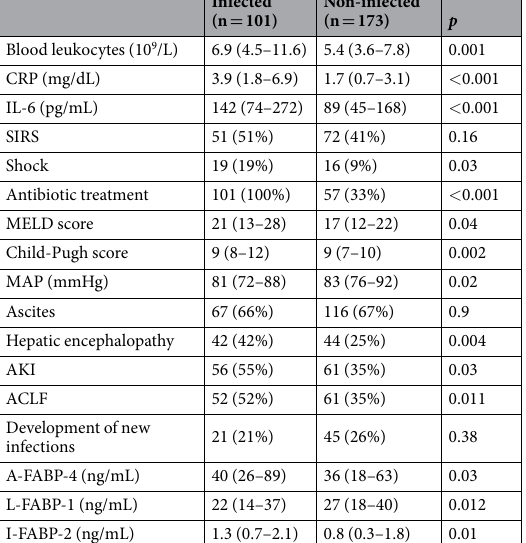
Table 3. Characteristics of patients according to the presence or absence of bacterial infection at admission. Categorical variables are expressed as numbers and percentages (in brackets), continuous variables are expressed as median (inter-quartile range). MELD, model of end stage liver disease; MAP: mean arterial pressure; AKI, acute kidney injury, ACLF: acute-on-chronic liver failure; A-FABP-4: plasma adipocyte fatty acid binding 4; L-FABP-1: plasma liver fatty acid binding 1; I-FABP-2: plasma intestinal fatty acid binding 2.